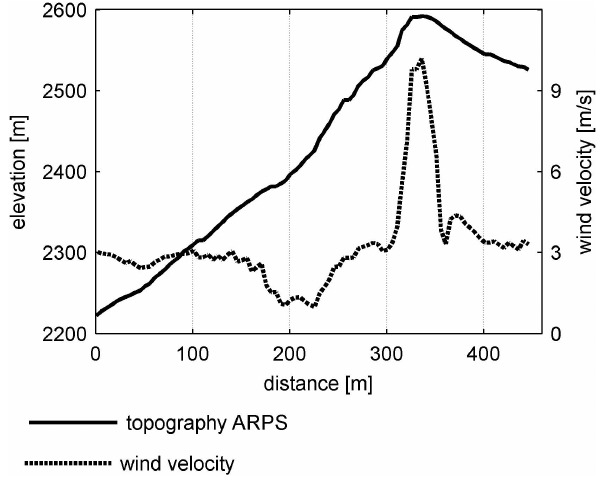
Fig. 5. Transect of the topography and modeled wind velocity cross- ing the Ch¨upfenflue in flow direction for NW storms (initialized vw = 3ms − 1 at 2400ma.s.l.). Transect is shown in Fig. 1,